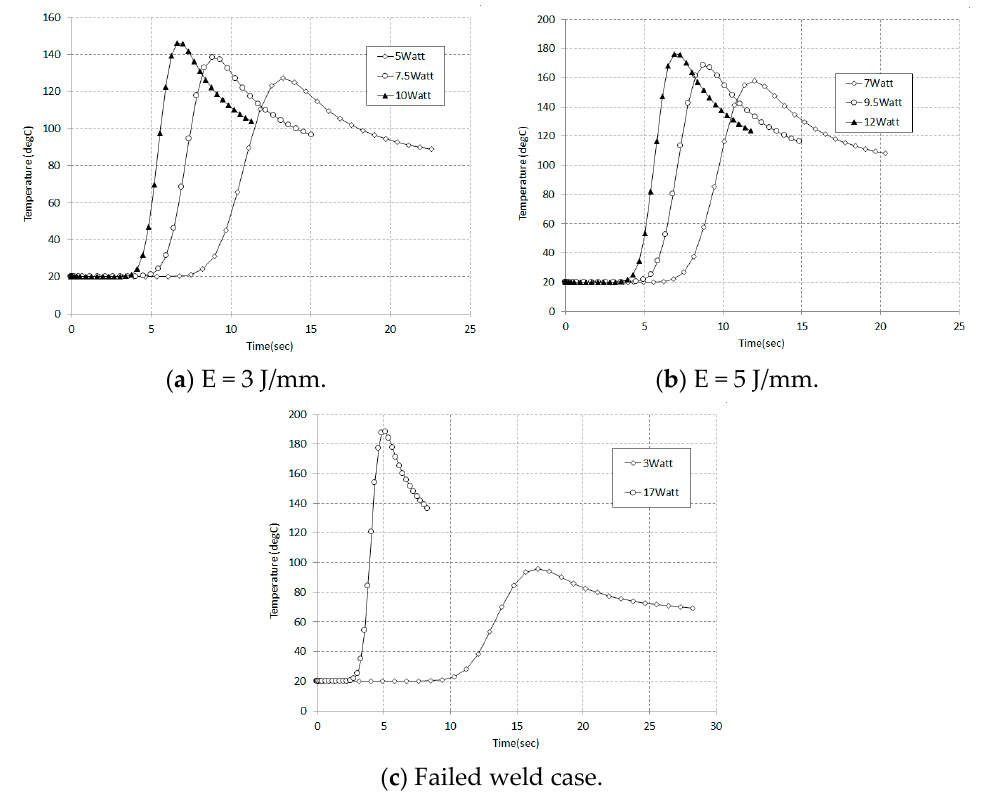
Figure 8. Temperature distribution for different heat inputs.